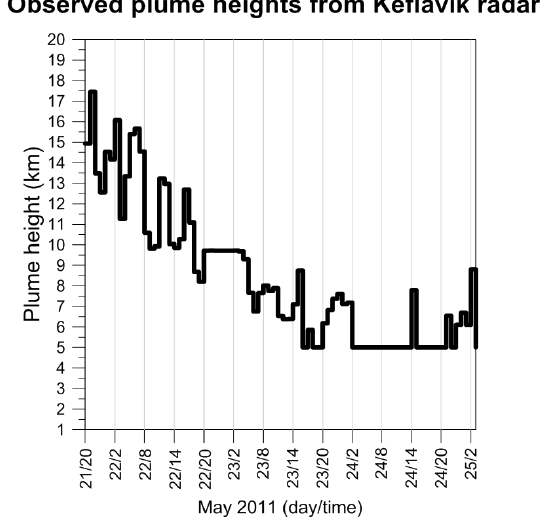
Figure 3. Observed plume heights (a.g.l.) from the Keflavík radar from 21 until 25 May 2011 during the eruption of the Grimsvötn